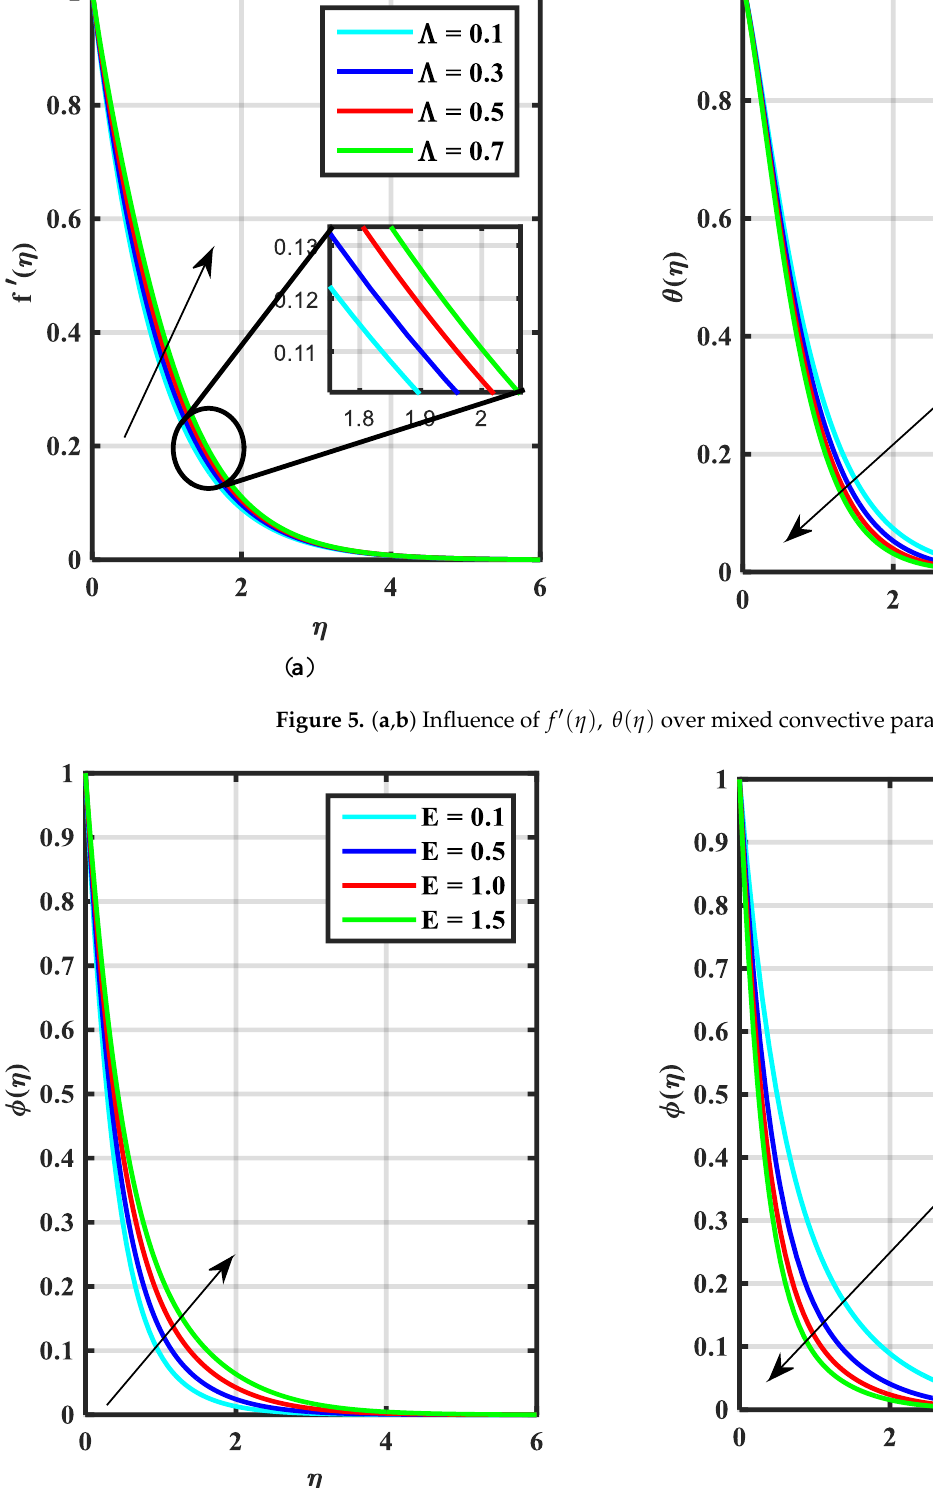
Figure 6. ( a , b ) Influence of